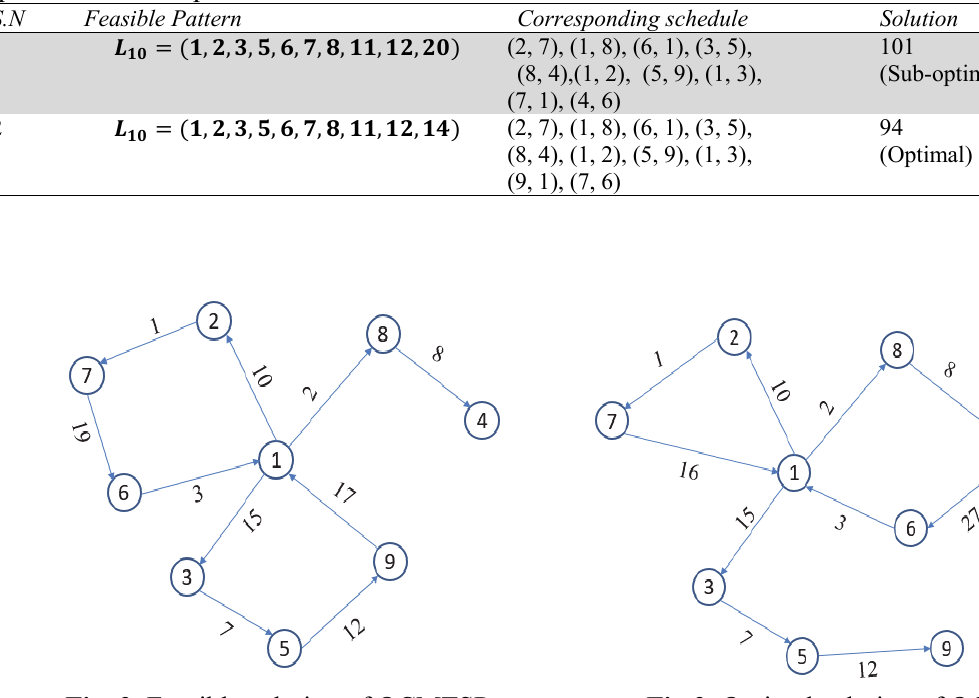
Fig. 2. Feasible solution of OCMTSP Fig.3. Optimal solution of